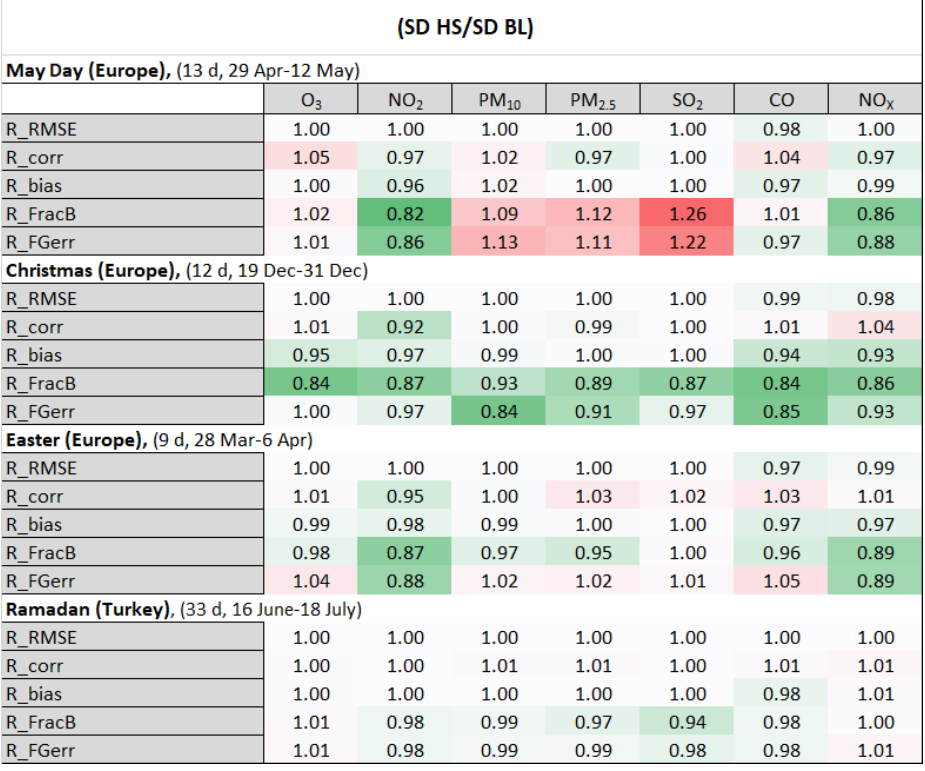
Figure 2. Summary of the R value for the main European holidays in 2018 for the considered air pollutants (the effect of Ramadan is assessed for Turkey only).